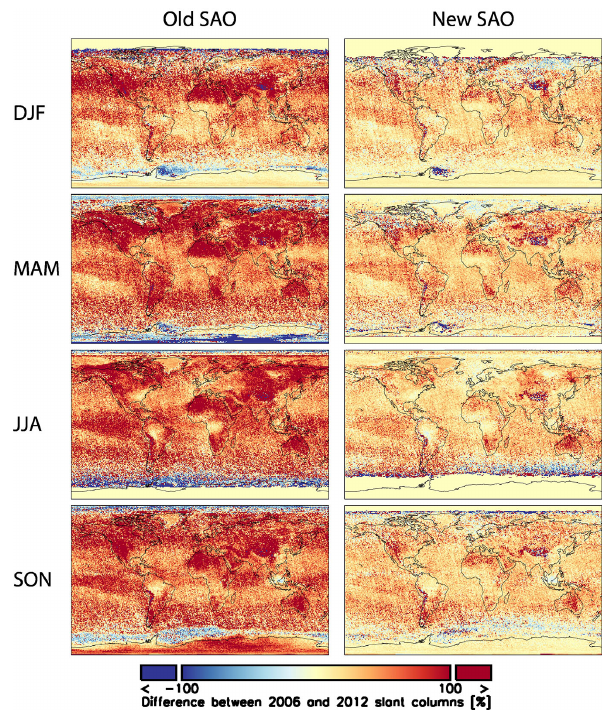
Figure 12. Difference between 2006 and 2012 slant column sea- sonal averages. Left column shows results for the old SAO retrieval, while the right column shows results for the new